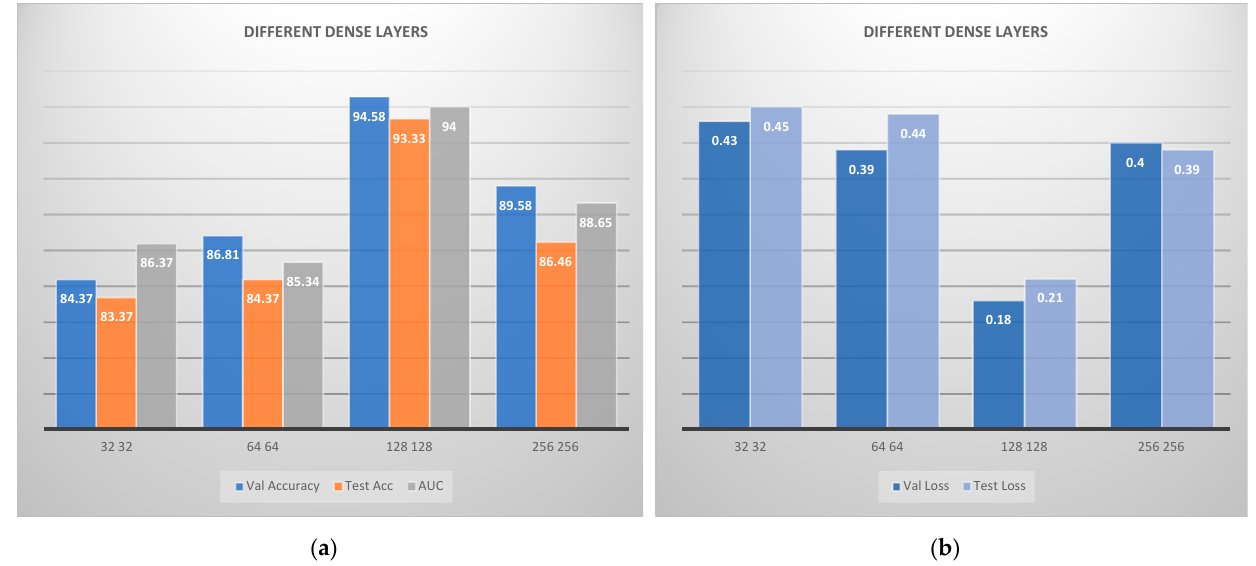
Figure 6. Convolutional neural network architecture for CAD classification problem comparing various fully connected layers: ( a ) accuracies; ( b ) losses. VAL is the validation accuracy and ACC is the accuracy.